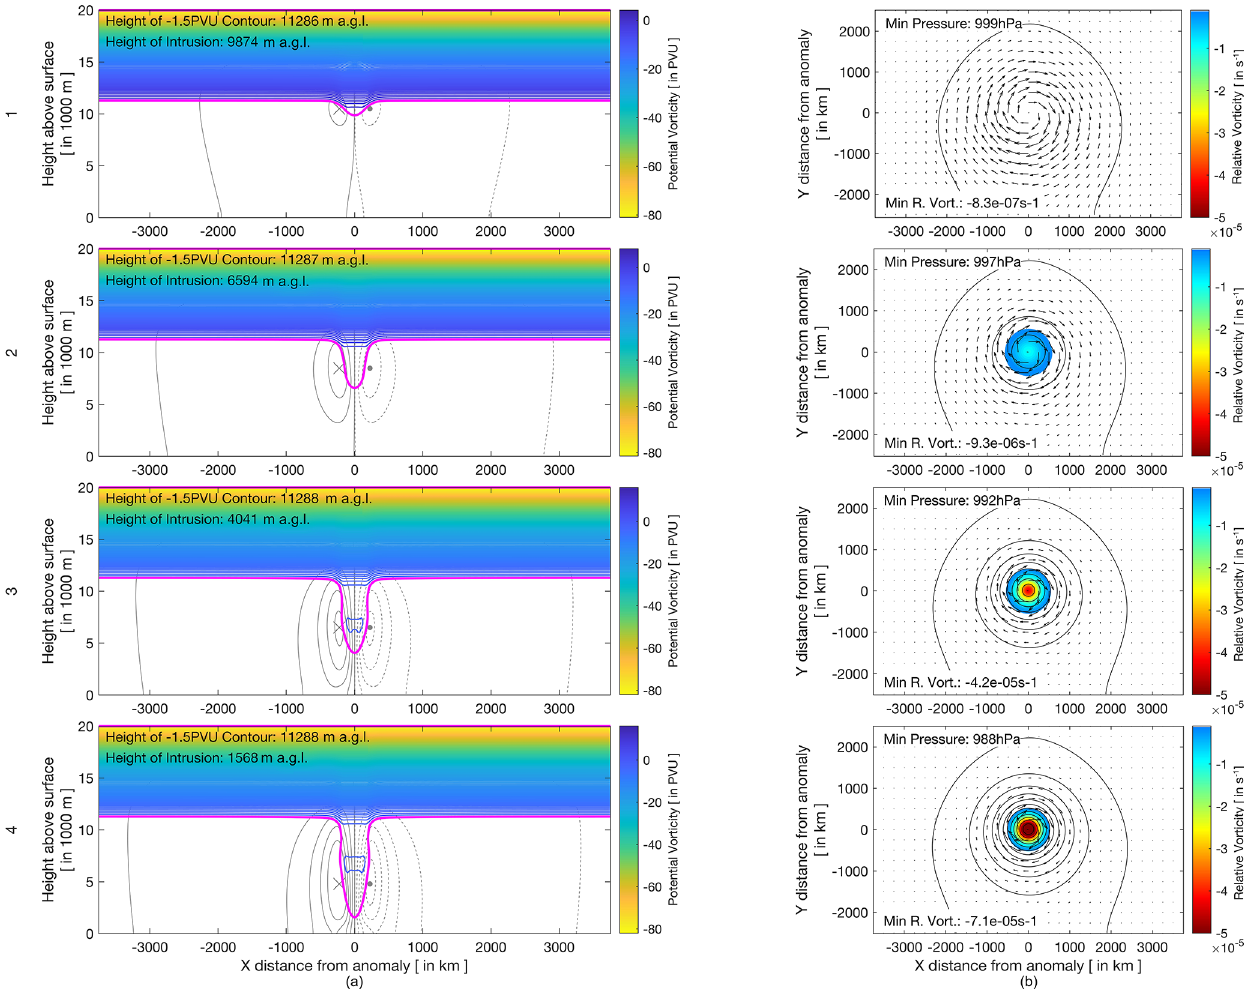
Figure 7. (a) Longitudinal PV cross-sections through the centre of the forced anomaly. The − 1.5PVU contour (our definition of the dynami- cal tropopause for this study) is highlighted by a thick magenta line. Meridional wind velocities are given in 4ms − 1 intervals shown by grey contours. Positive velocities (into the page) are represented by solid contours, whilst negative velocities are represented by dashed contours (out of the page). (b) The effect of the intrusion on the surface pressure and relative vorticity are shown in the right panels. Pressure isobars at a 1hPa contour interval are shown by black lines, whilst relative vorticity is shown by the shading. The panels in rows 1–4 represent different varying stratospheric depths introduced into the domain. For this experiment (Experiment 1), radial anomaly depths given to the system are 2500m (row 1), 5000m (row 2), 7500m (row 3) and 10000m (row 4). By convention, in-text figure references refer to the column letter and the row number of the panel referenced (i.e. b2 refers to the panel in column b and row